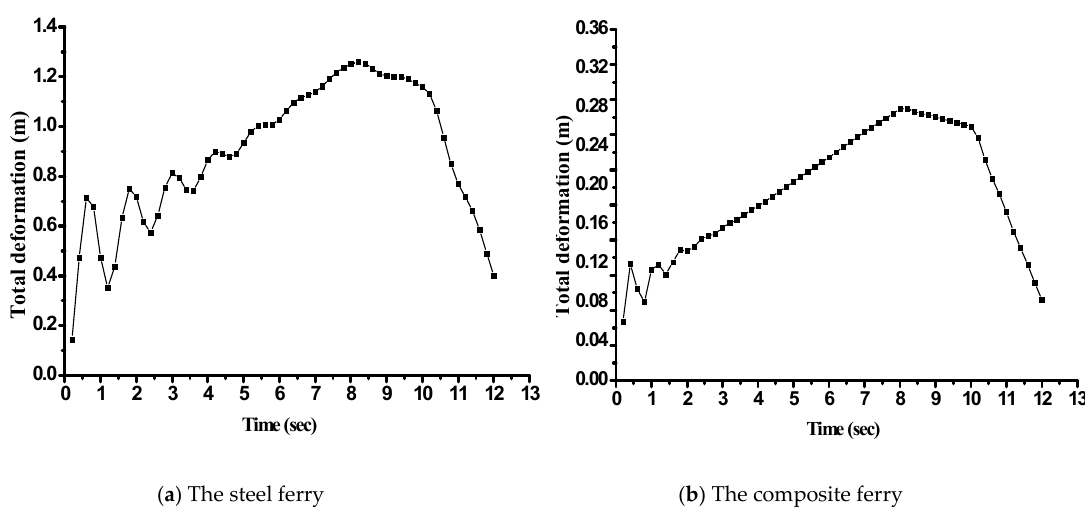
Figure 28. The total deformations with time for case 3.